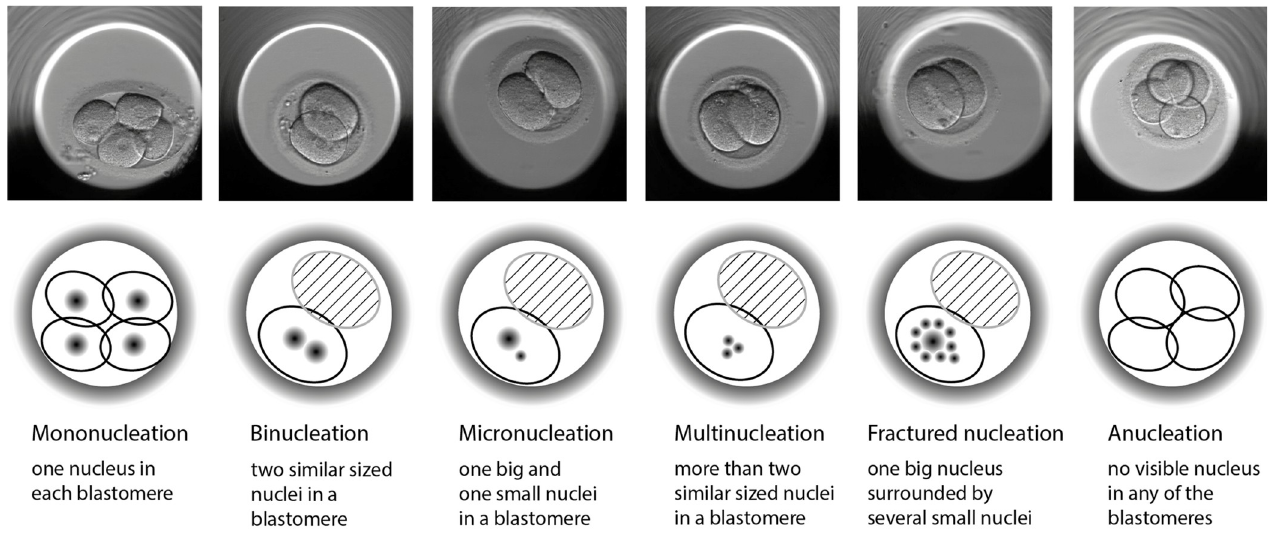
Fig 1. Illustration of the different nucleation error phenotypes (NEP) in early preimplantation embryos.